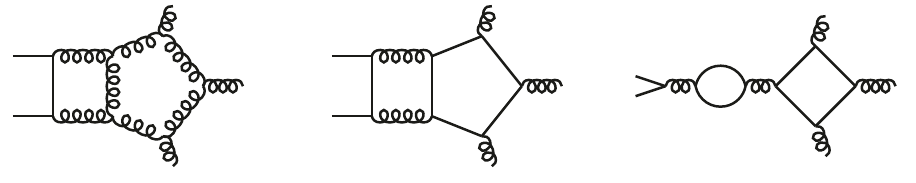
Figure 4 . Representative Feynman diagrams for leading-color A (2) ( q; (cid:22) q; g; g; g ) amplitudes, con- tributing at order N 0